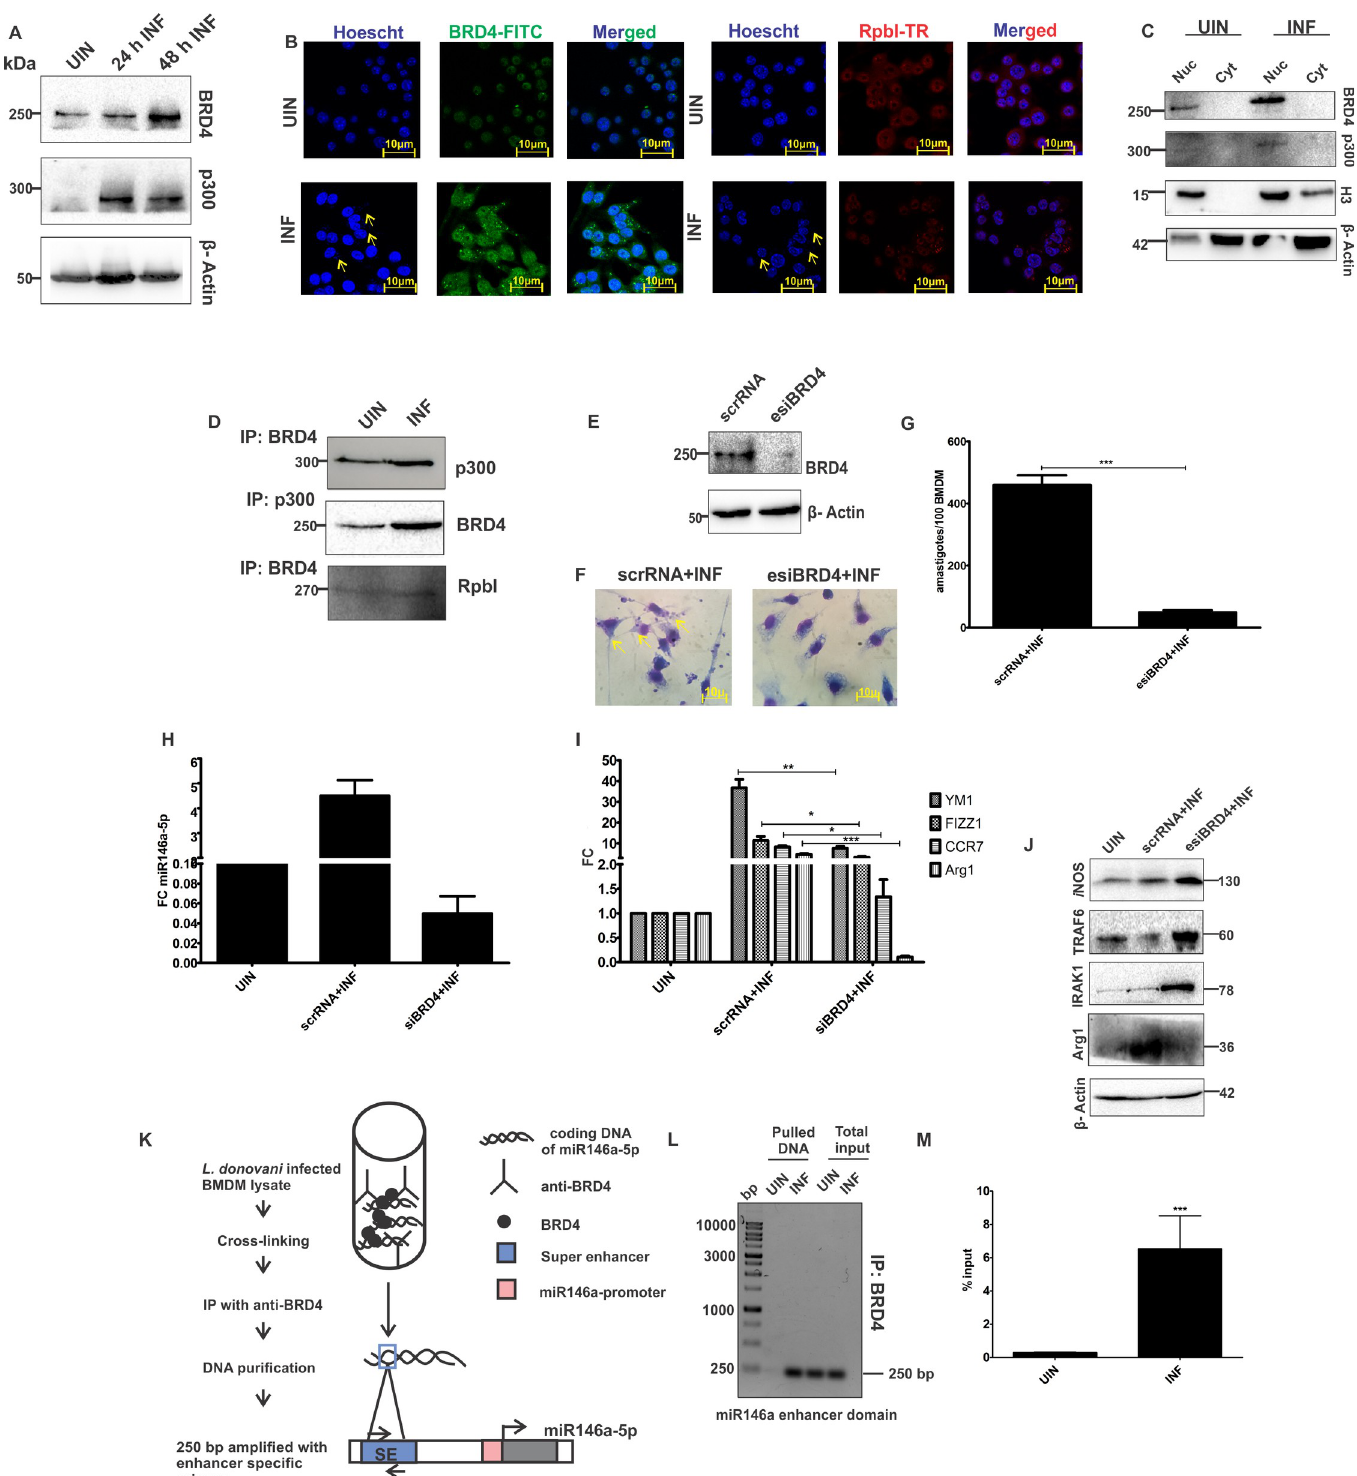
Fig 6. BRD4 mediated super enhancer complex ensures prolonged enrichment of miR146a-5p and M2 polarization profile of L . donovani infected BMDMs. (A) Western blotting of major super enhancer proteins like BRD4 and p300 in L . donovani infected BMDMs. (B) Nuclear localization of BRD4 and RNA polymerase subunit I (RpbI) were determined by confocal micrographs of uninfected and infected BMDMs. Representative images were obtained at 63X oil immersion objective (scale bar- 10 μ m) with 2.0 zoom factor and processed using LAS-X software. (C) Nuclear and cytosolic fractions of infected BMDMs were subjected to western blotting for BRD4